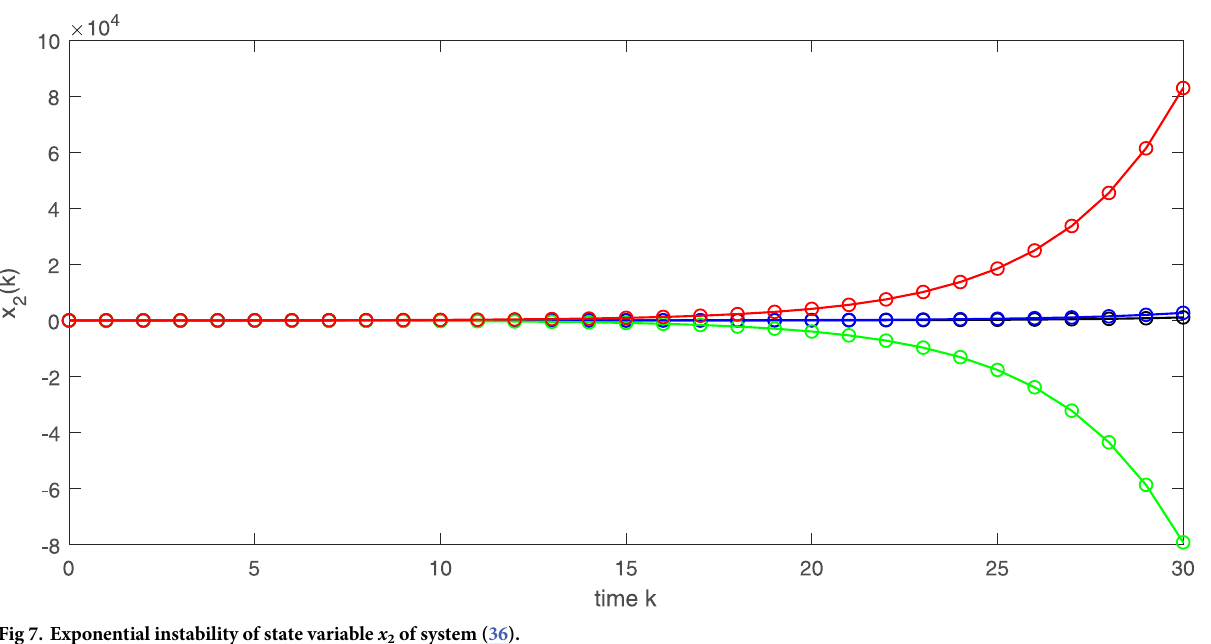
Fig 7. Exponential instability of state variable x 2 of system (36).